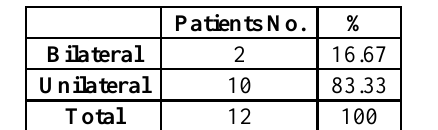
Table 2: Distribution of patients with